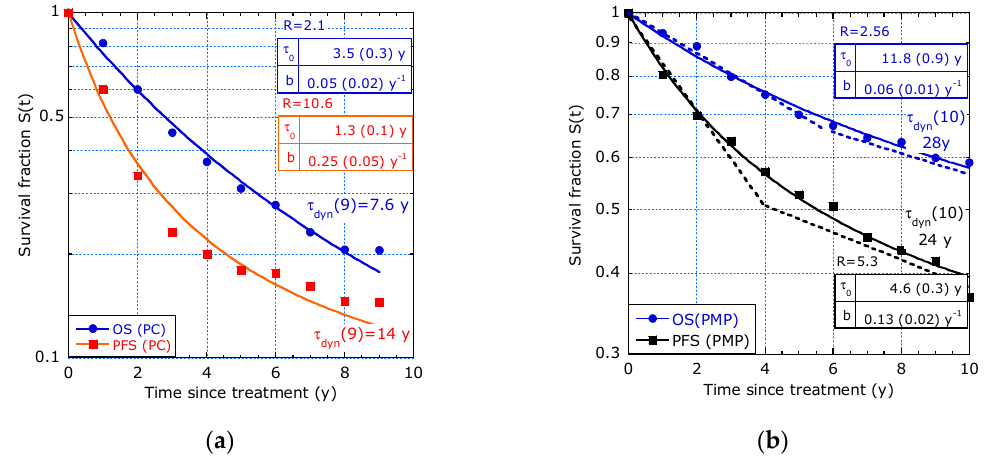
Figure 8. OS and PFS fitted to the sliding- τ model from ([9], Figure 2a,b): ( a ) Patients selected on PC; ( b ) Patients selected on PMP.